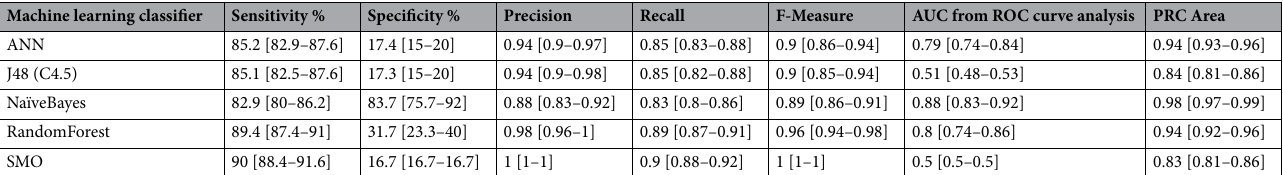
Table 3. Detailed results of machine learning-based classification of 5-year major adverse cardiovascular and cerebral events [95% confidence interval]. ANN Artificial neural network (multilayer perceptron), AUC area- under-the-curve, PRC precision recall curve, ROC receiver operator characteristics, SMO sequential minimal